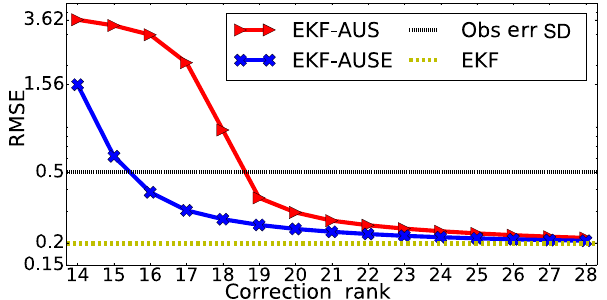
Figure 3. Box plot statistics of the local Lyapunov exponents, for Lyapunov exponents 14 through 29, over 10 5 realizations for the 40 dimensional L96 model. The mean ( i -th Lyapunov exponent) is plotted as a triangle with median the horizontal line. Box contains inner two quartiles of realizations, with whiskers extending to 1.5 the inner quartile width from the third and first quartile. Outliers are realizations outside of this range, plotted